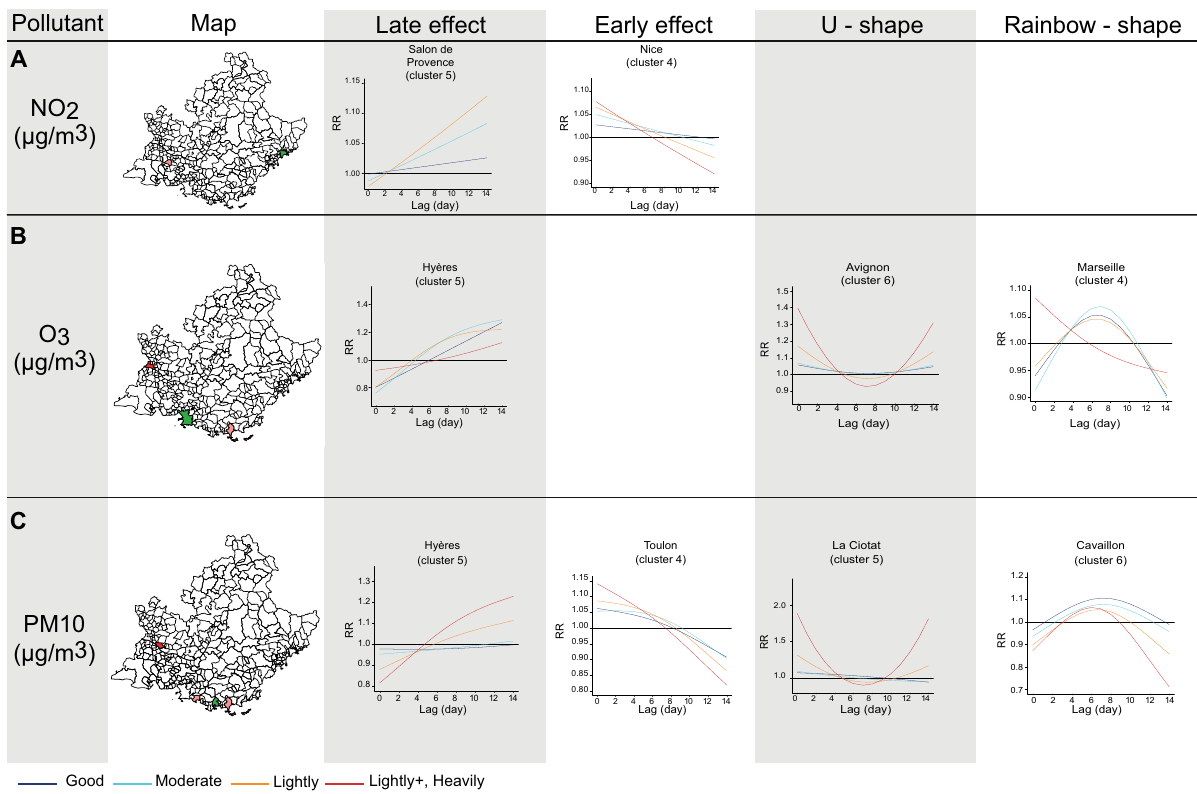
Figure 5. DLNM by singular zones, only significant results for the selected 23 zones are reported. Lag-specific effect on CD events for increases of NO 2 (A) , O 3 (B) and PM10 (C) over the thresholds indicated in the legend in the plot. Only the most representative plot is reported for each pollutant and shape of the response-effect curves. Others zones showing similar trends are reported in Supplementary Fig. 5. Maps were created with the R package maptools